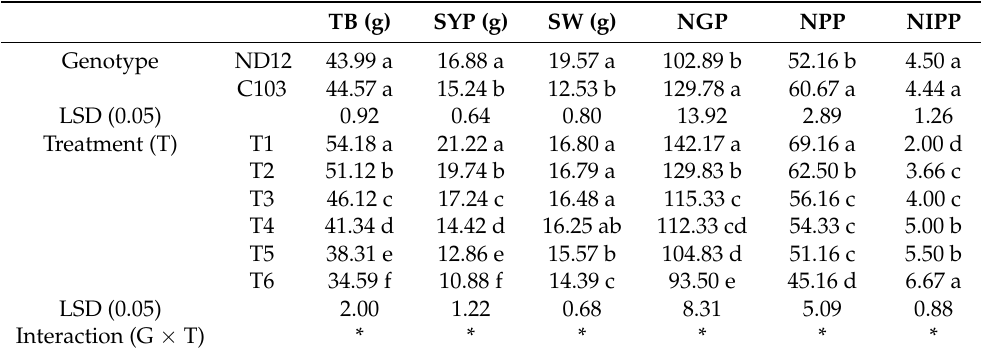
Table 2. Soybean yields and yield components, and total biomass accumulation under different split-root water imbalance